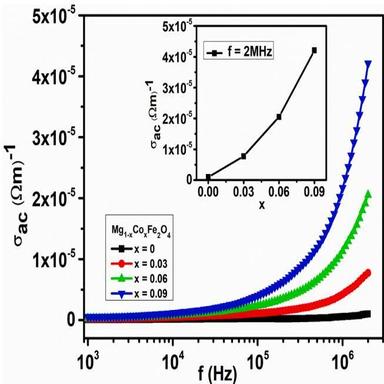
Variation of ac-conductivity versus frequency (Hz) of Mg1-xCoxFe2O4 with (x = 0, 0.03, 0.06, and 0.09) nanoparticles, while insets show variations of Co concentrations versus ac- conductivity.